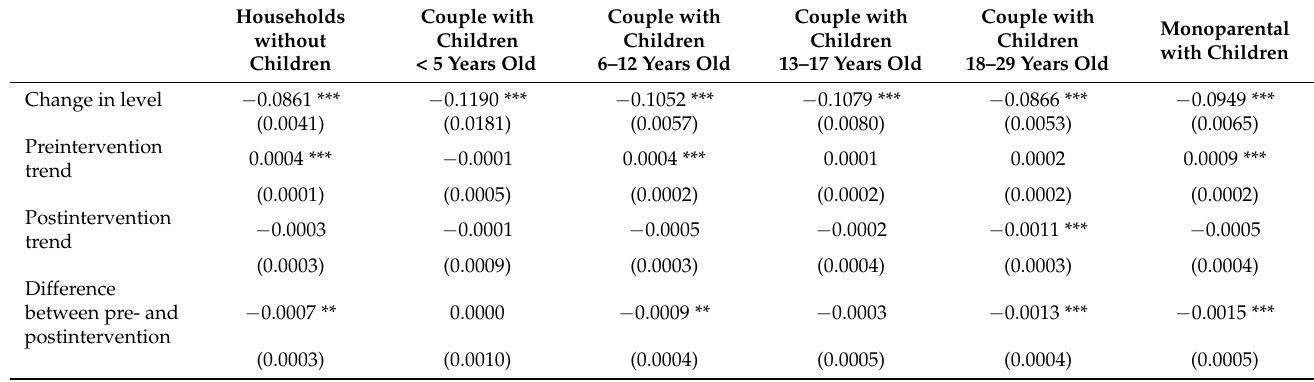
Table 5. Marginal effects on budget shares and trends before and after the intervention by life